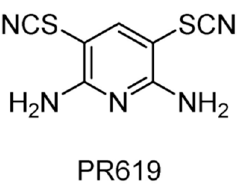
Figure 8. Structure of compound PR619.